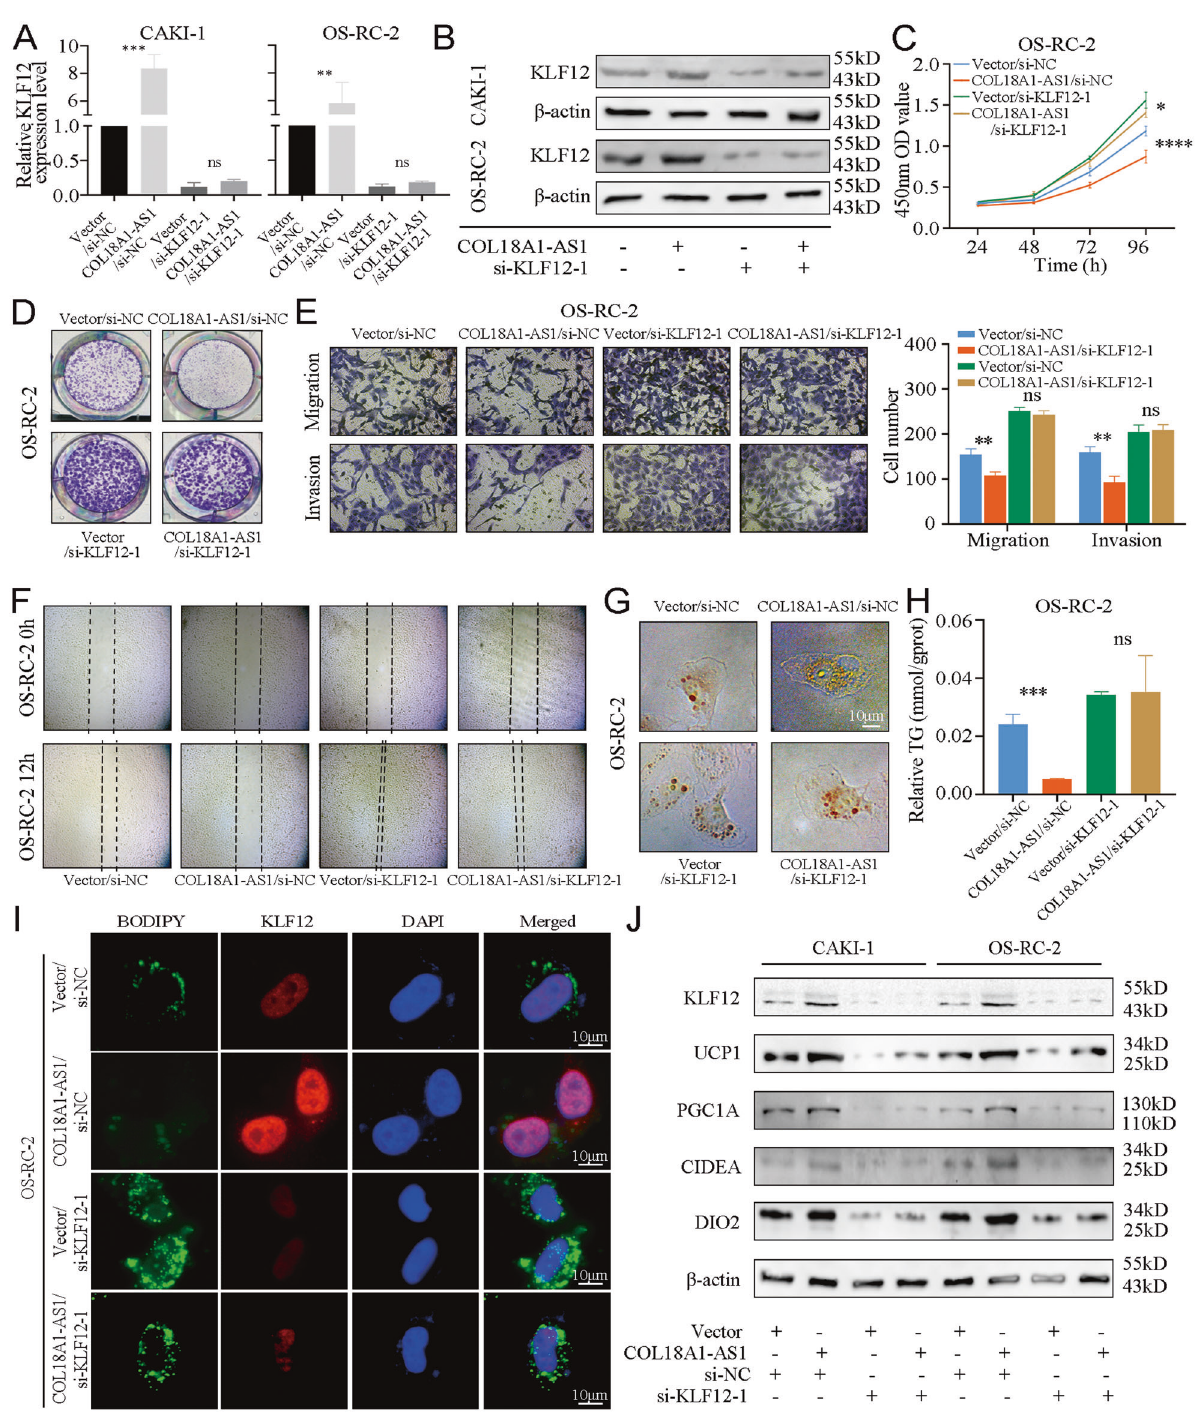
Fig. 6 COL18A1-AS1/KLF12 axis repressed ccRCC progression through UCP1-mediated lipid browning. A , B qRT-PCR and Western blotting assays showed the expression level of KLF12 in CAKI-1 and OS-RC-2 cells co-transfected with COL18A1-AS1 vector and/or si-KLF12. C , D Cell proliferation ability of OS-RC-2 cells co-transfected with COL18A1-AS1 vector and/or si-KLF12 was determined using CCK8 assays or colony formation assays. E , F Cell migration and invasion ability of OS-RC-2 cells was measured with Transwell assays or wound healing assays (Magni fi cation: ×100 for Transwell assays and x40 for wound healing assays). G Photomicrographs of Oil Red staining of OS-RC-2 cells. Scale bars, 10 μ m. H Relative TG (mmol/gprot) levels in OS-RC-2 cells assessed by a triglyceride assay kit. I Representative photographs of IF staining for lipids with BODIPY 493 of 503 (green) and KLF12 (red) in the cells co-transfected with COL18A1-AS1 vector and/or si-KLF12. Cell nuclear appear in blue (DAPI). Scale bars, 10 μ m. J Protein levels of lipid browning marker genes (UCP1, PGC1A, CIDEA, and DIO2) in CAKI-1 and OS-RC- 2 cells co-transfected with COL18A1-AS1 vector and/or si-KLF12 assessed by western blotting. * P < 0.05, ** P < 0.01, *** P < 0.001, **** P < 0.0001. Error bars indicate mean ± SD. All the experiments were performed in triplicate.